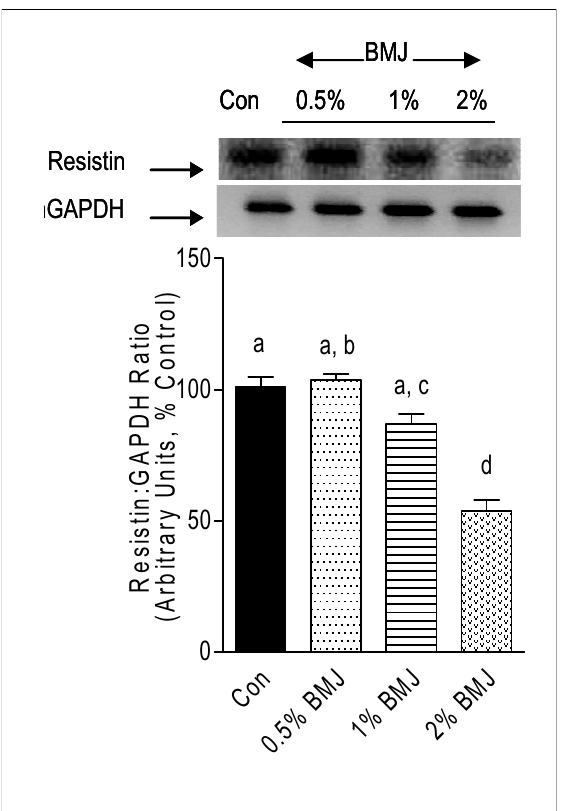
Figure 5 Effect of bitter melon juice on SREBP-1c mRNA expres- sion . Differentiating preadipocytes treated with varying concentra- tions of BMJ (0.5% to 2%, v/v) demonstrate a significant reduction in SREBP-1c mRNA gene expression. Bar graphs depict the densitometry scans of SREBP gene amplicons (238-bp) and are expressed as a ratio to GAPDH amplicon (298-bp) intensity. Data are expressed as a per- centage of the control (set as 100%) and the values represent the mean ± SE (n = 6) of three independent experiments analyzed in du- plicate. a, b, c Mean values with common letters do not differ (p < 0.05).